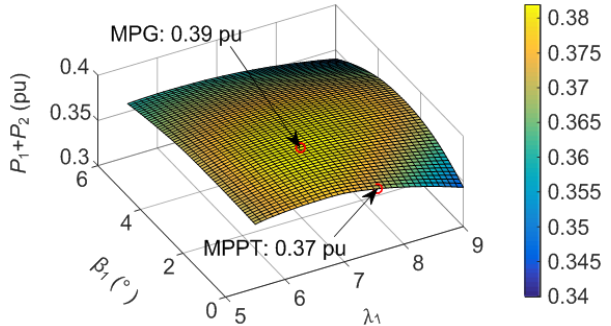
Figure 8. Total active power of the wind farm in terms of the pitch angle and tip speed ratio of WT 1 at 270° wind direction and 9 m/s ambient wind speed.